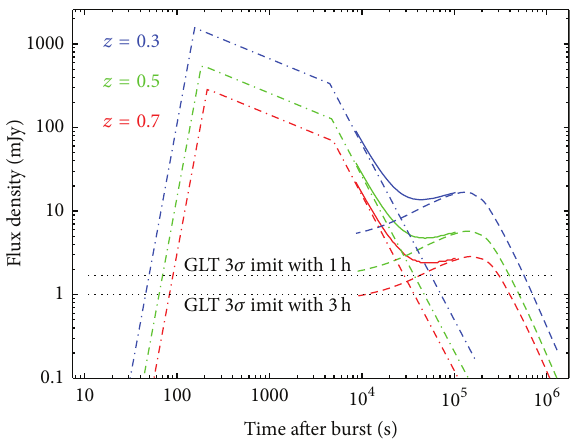
Figure 7: Expected spectrum at the deceleration time with 𝑧 = 1 , 𝐸 = 1 × 10 52 , Γ = 80 , 𝑛 = 1 , 𝜖 = 0.01 . Synchrotron radiations from reverse and forward shock 𝜖 𝐵, FS areindicatedbyredsolidandbluedashedlines,respectively.Agreen hatched box indicates the frequency coverage of GLT.